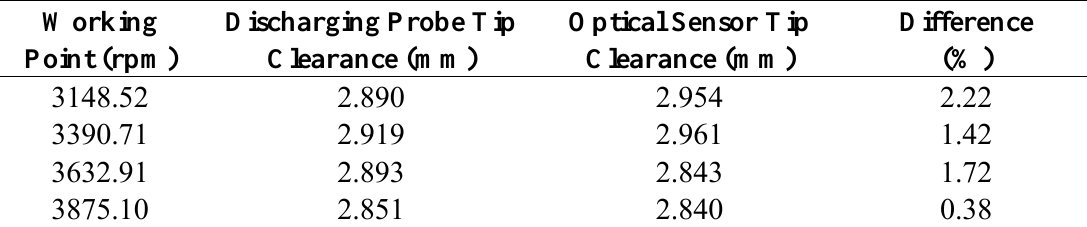
Table 1. Tip clearance measurements obtained during turbine